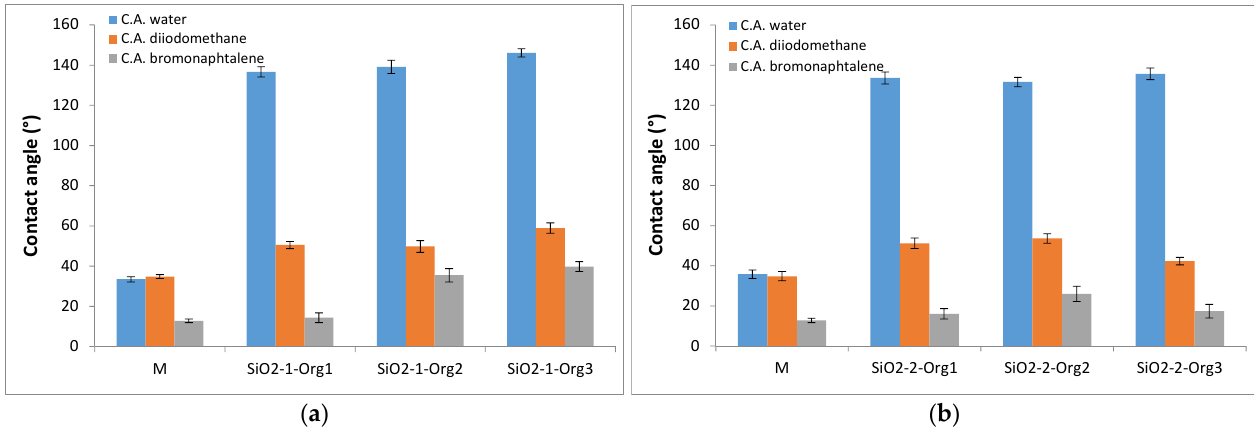
Figure 8. Variation of contact angle values for water, diiodomethane, and bromonaphtalene on silica samples prepared with different TEOS/DDETS ratio: Series TEOS:NH 4 OH:H 2 O = 1:3.4:15.2 ( a ); and Series TEOS:NH 4 OH:H 2 O = 1:12.7:57.3 ( b